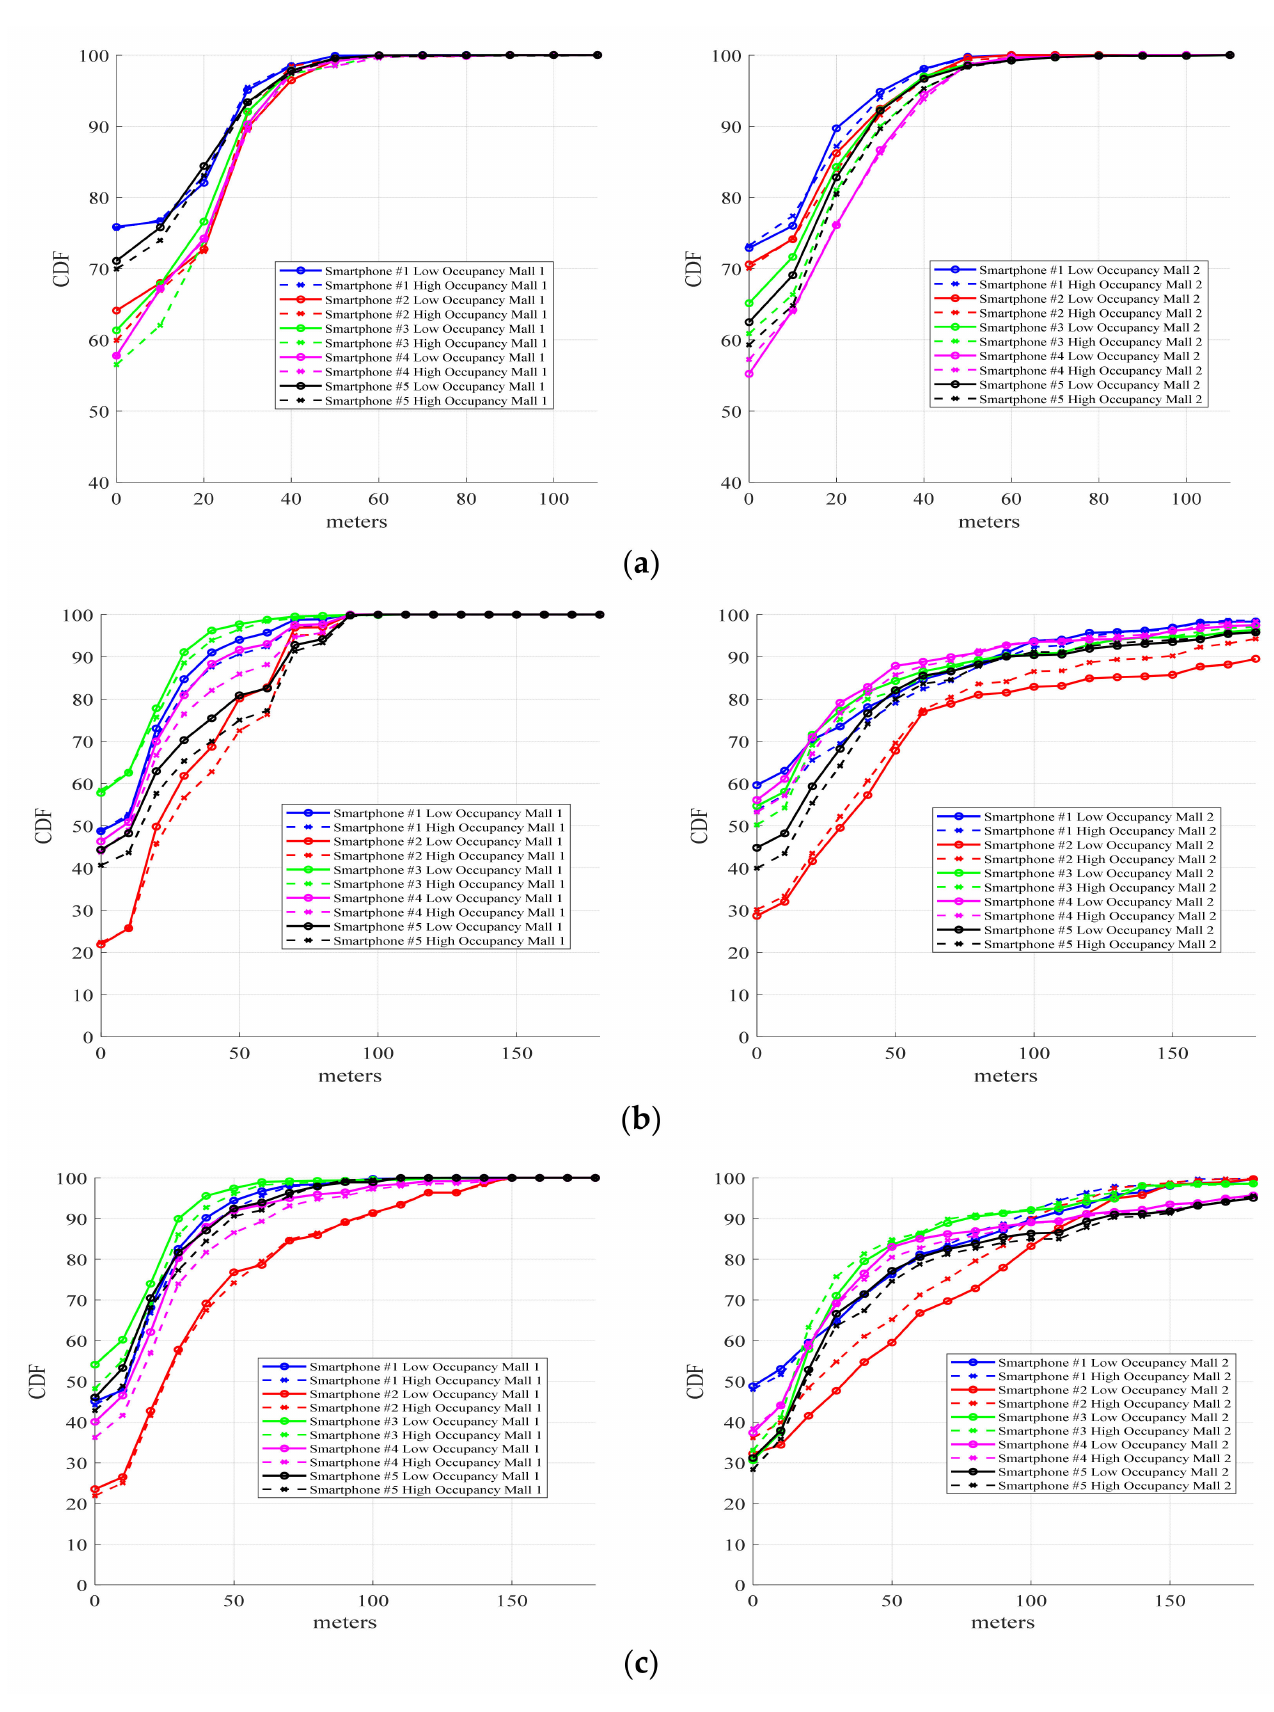
Figure 10. Influence of occupancy rates on the IPS generated with ( a ) Freeloc, ( b ) KNN, and ( c )